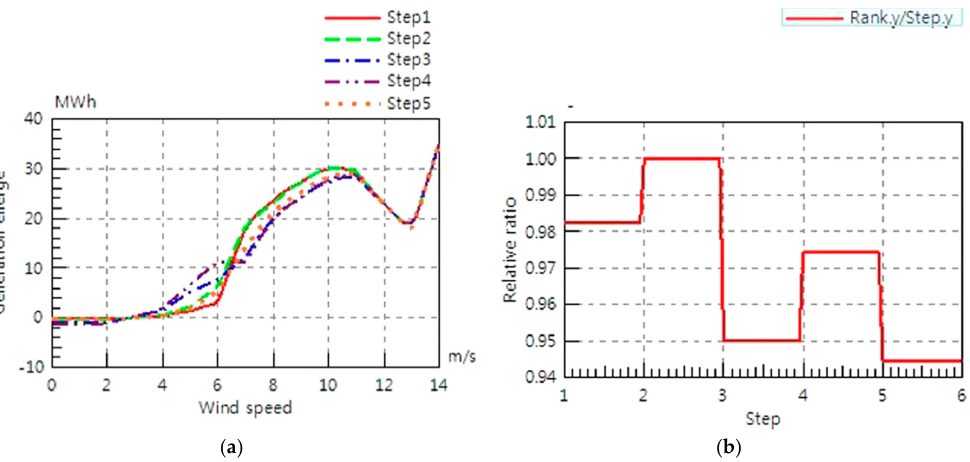
Figure 12. System power generation according to powertrain combination. ( a ) Torque map and ( b ) generation efficiency.